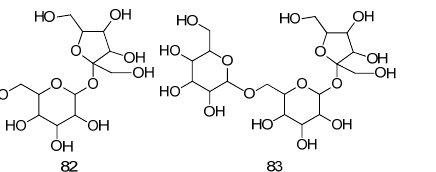
Figure 7. The chemical structures of polysaccharides identified from Fructus Malvae .